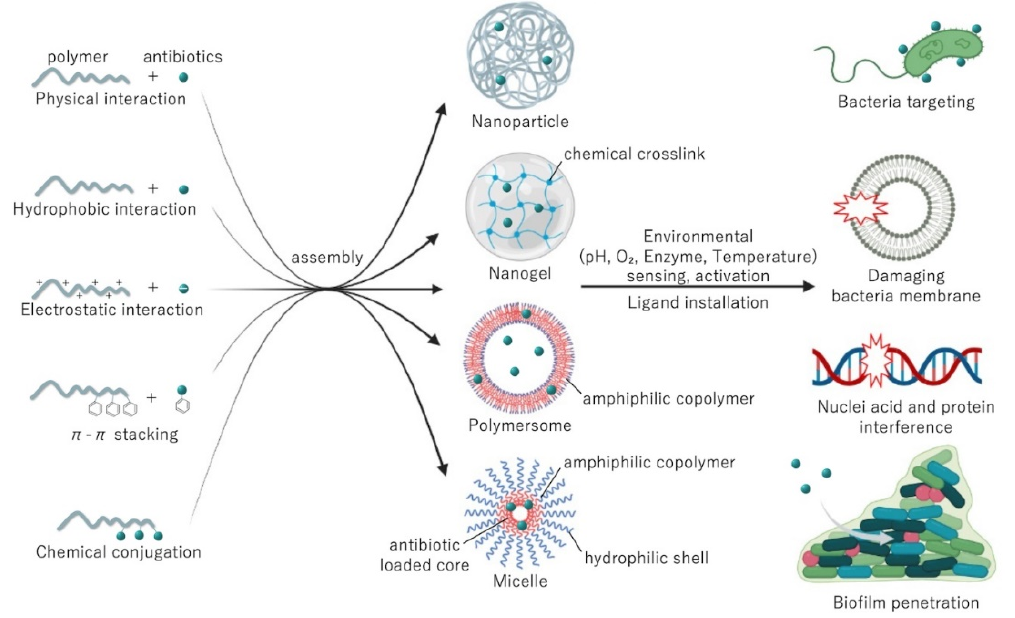
Figure 4. The assembly strategies and mechanism of actions of antibiotics loaded in polymeric delivery systems.